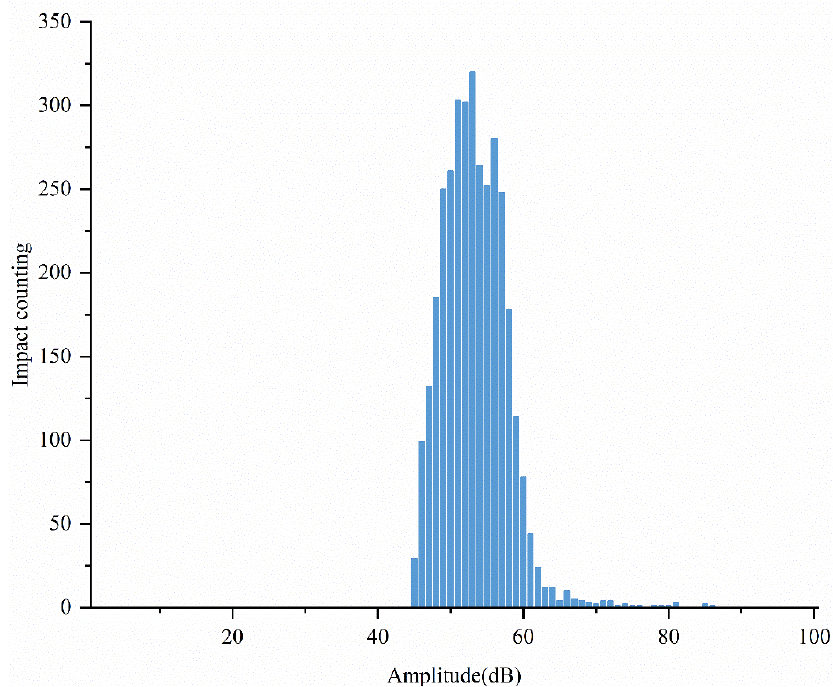
Figure 9. Impact-amplitude correlation diagram of cable noise signal of Yellow River Bridge.